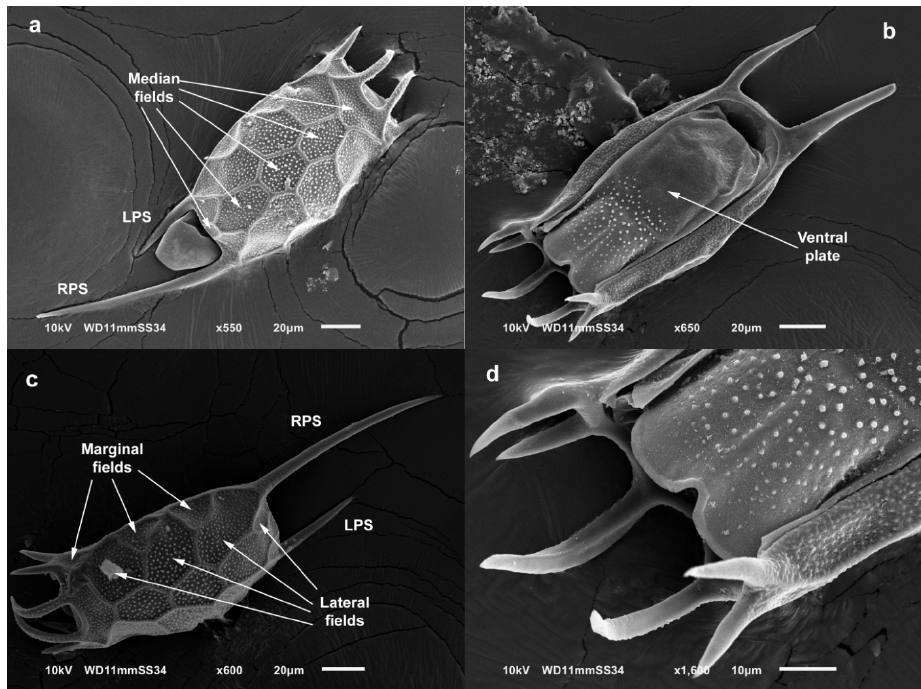
Figure 6. SEM photographs of Keratella tropica from Yuriria dam. ( a ). Dorsal view: arrows indicate the median fields, RPS (Right Posterior Spine), LPS (Left Posterior Spine). ( b ). Ventral view showing ornamentation over anterior part of the lorica. ( c ). Dorsal view: arrows indicate the lateral and the marginal fields, RPS (Right Posterior Spine), LPS (Left Posterior Spine). ( d ). Ventral view of the anterior part of the lorica.